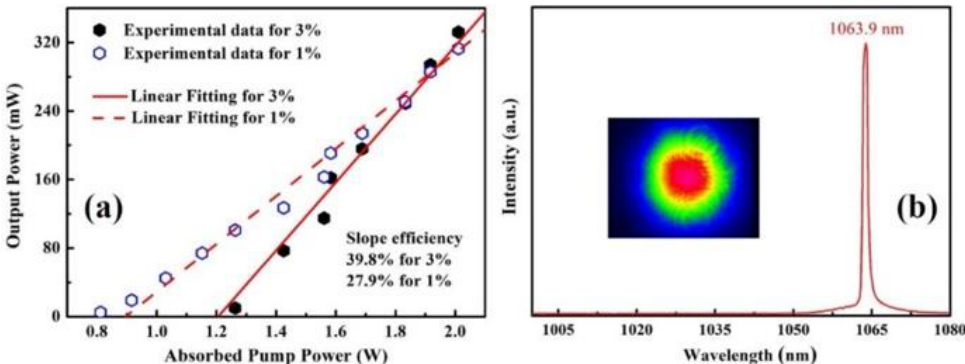
Figure 10. ( a ) Absorbed pump power versus average pulsed output power in the self-Q-switching operation (dots for the experimental data and lines for the linear fittings); ( b ) spectra and beam profile of the output laser. profile of the output